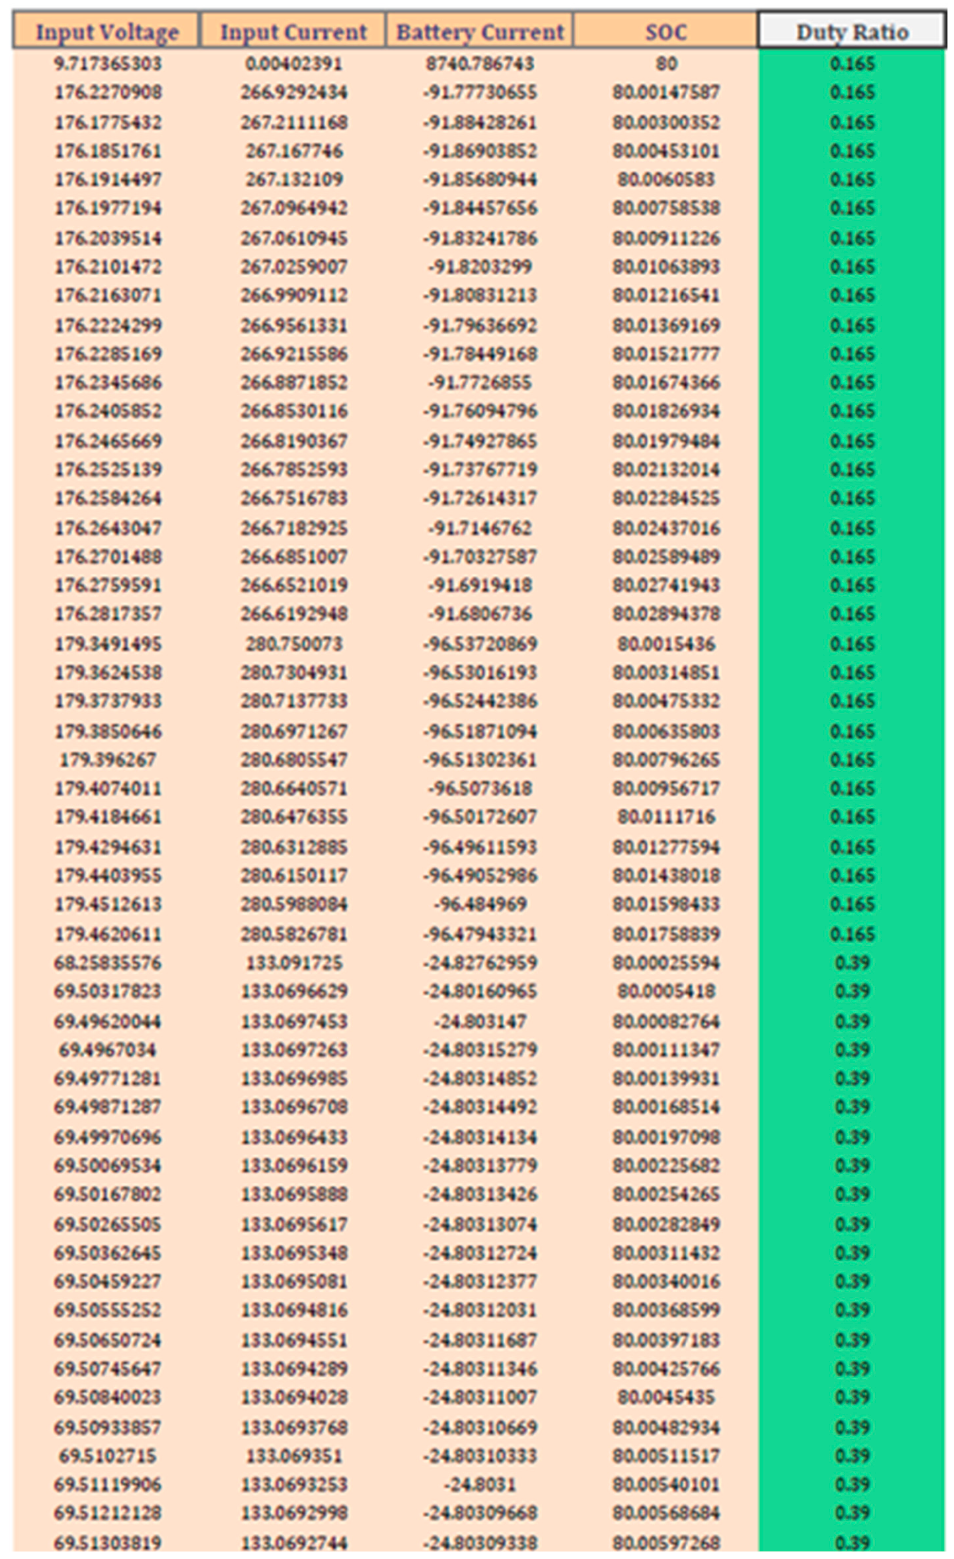
Figure 15. Input parameters and the output of ANFIS.